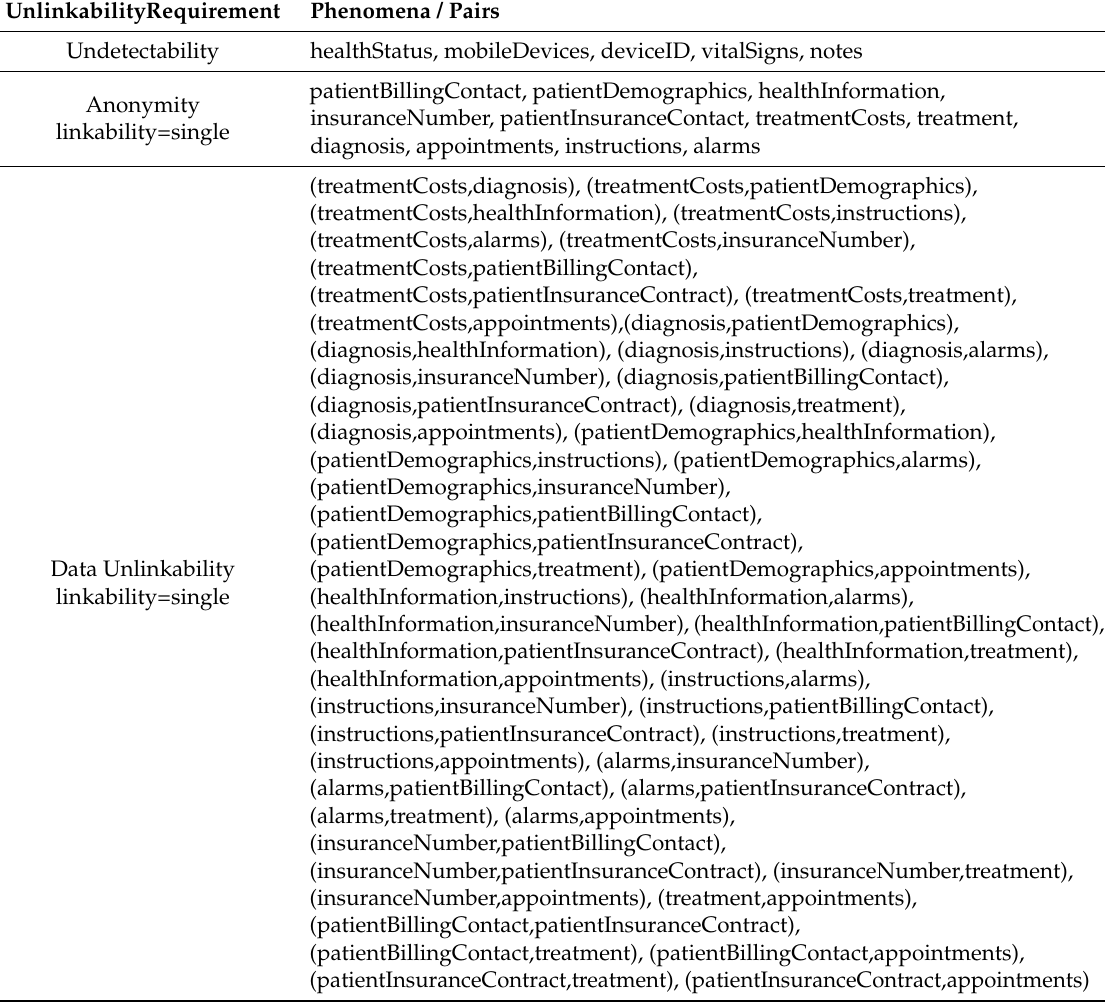
Unlinkability requirements for the stakeholder patient and the counterstakeholder insurance